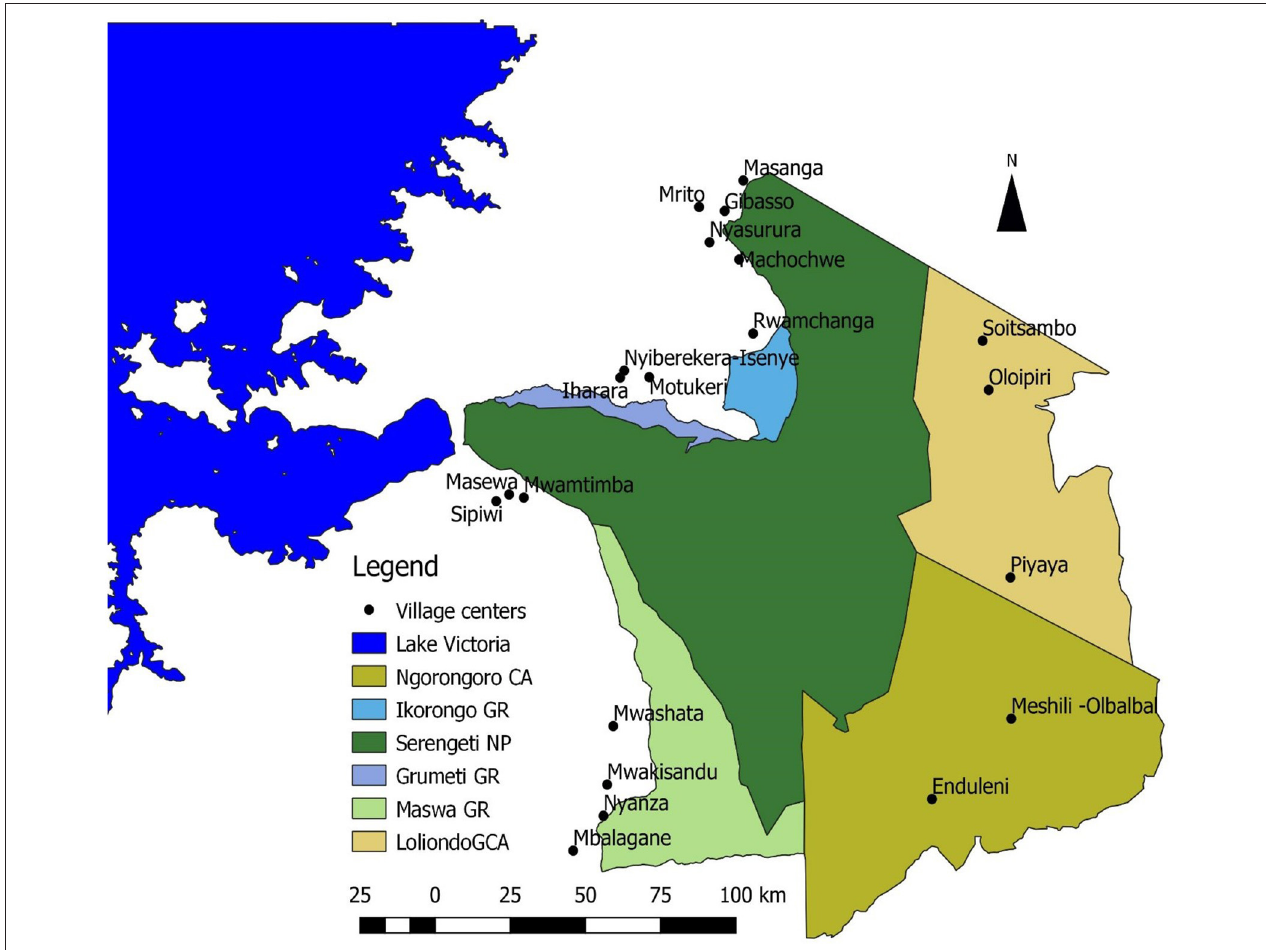
FIGURE 1 | Villages surveyed in the Greater Serengeti Ecosystem. CA, Conservation area; GR, Game Reserve; NP, National Park; GCA, Game Controlled Area; only part of Lake Victoria shown.